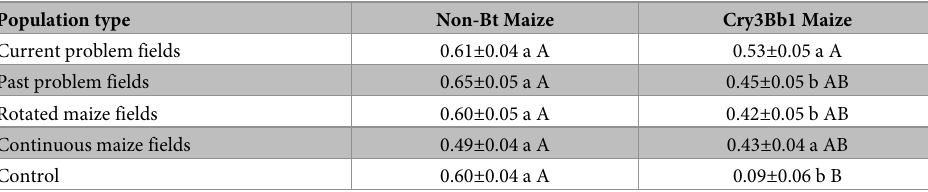
Table 2. Proportion of third instar larvae on Cry3Bb1 maize and non-Bt maize 1